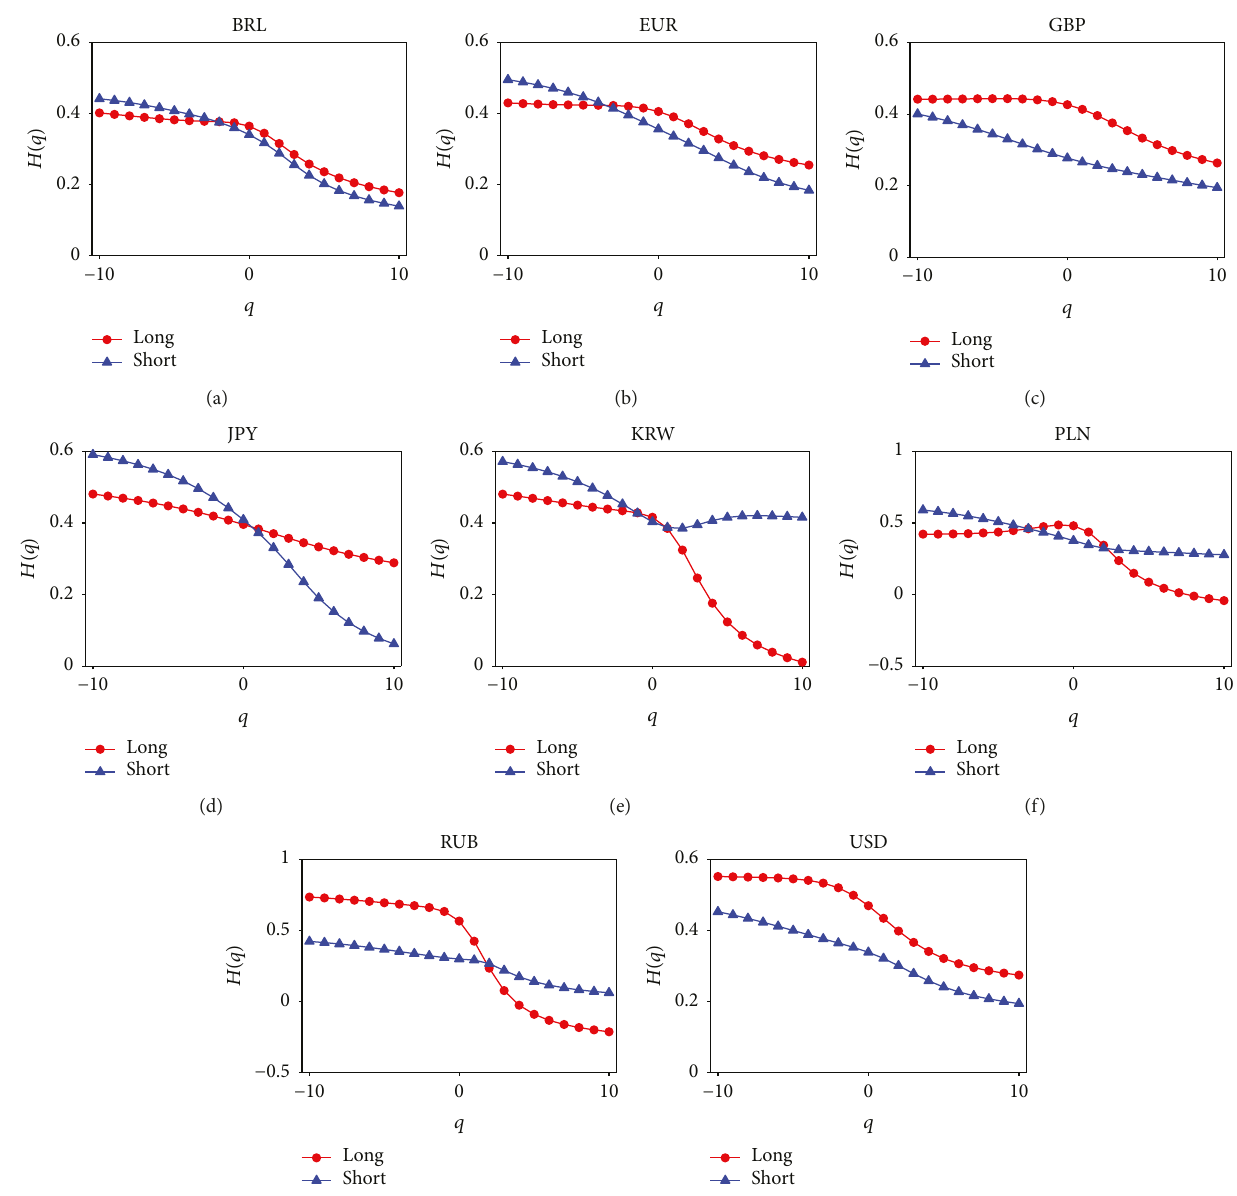
Figure 9: The long-term and short-term generalized Hurst exponent values H